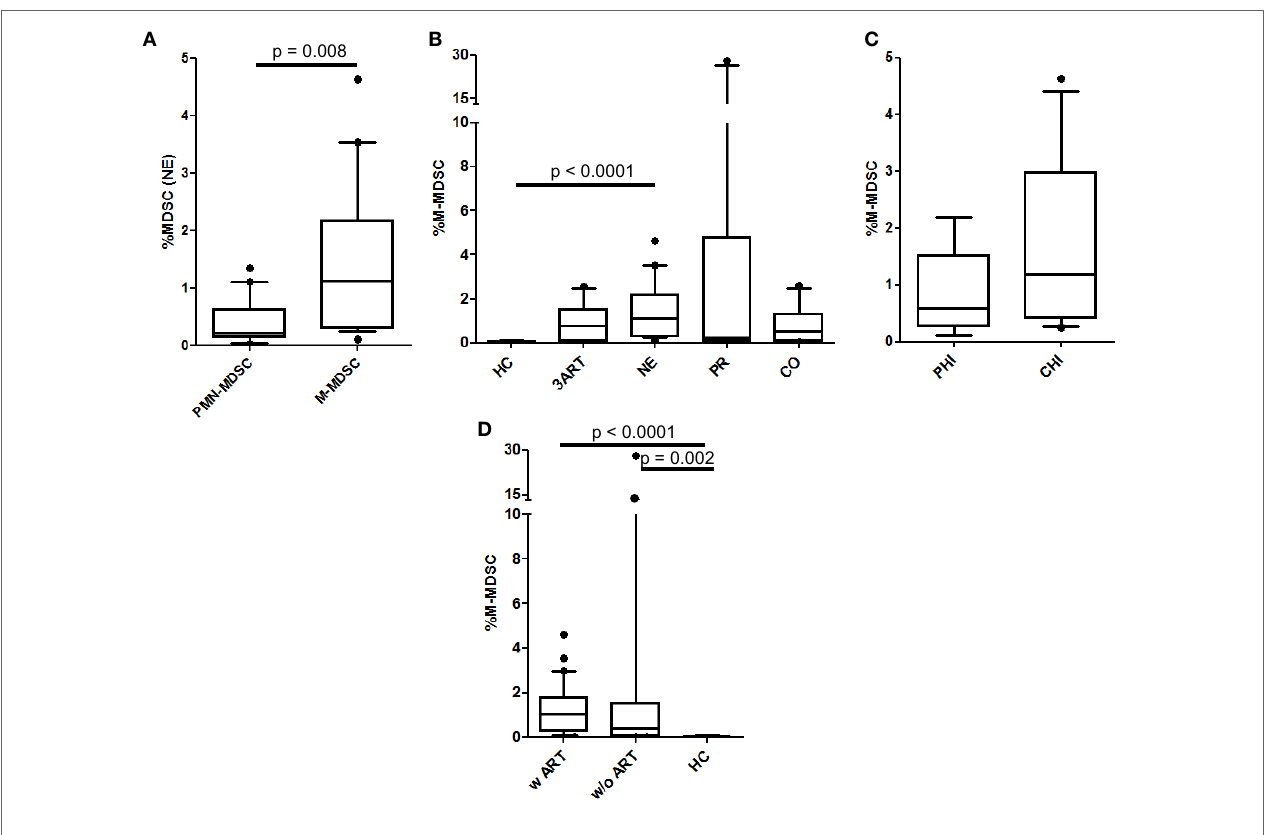
FigUre 2 | Monocytic myeloid-derived suppressor cell (M-MDSC) frequencies. (a) Polymorphonuclear myeloid-derived suppressor cell (PMN-MDSC) levels were significantly lower than M-MDSCs in the New Era (NE) population ( p = 0.008). (B) M-MDSCs in the NE group were similar to the 3ART patients. (c) Comparable frequencies in the subgroups primary HIV infection (PHI) and chronic HIV infection (CHI) ( p = 0.2). (D) The M-MDSC levels in the patients with antiretroviral therapy (w ART) and w/o ART were significantly increased compared with the HIV-uninfected controls (HC) group ( p < 0.002) [HC: n = 10; 3ART: n = 10; NE: n = 19 (PHI: n = 8; CHI: n = 11); progressors (PR): n = 10; CO: n =